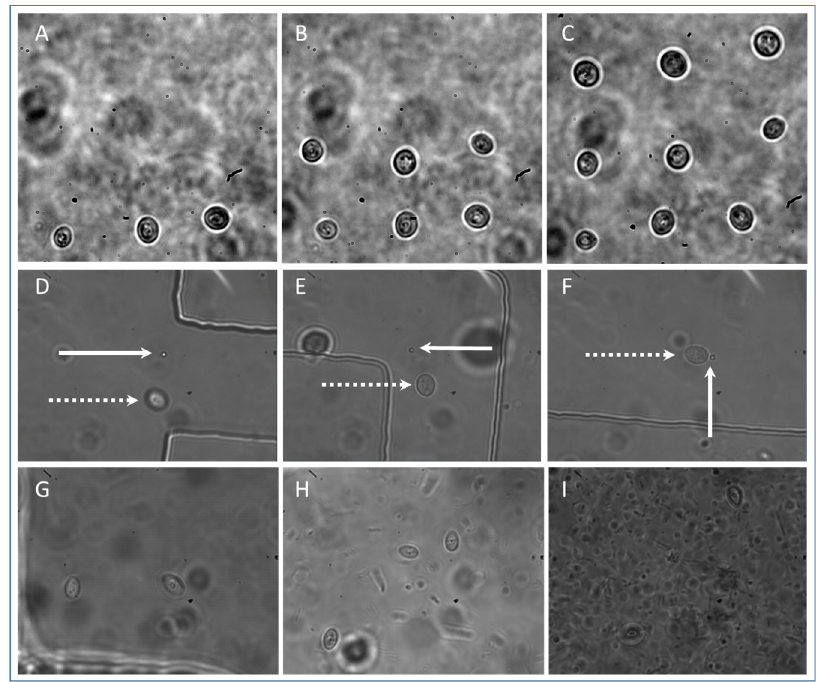
Figure 8. Setting up co-culture, ( A – C ) the creation of a 3 × 3 array of yeast cells; ( D – F ) a single S. cerevisiae yeast (dashed arrow) and single E. coli bacteria (solid arrow) tweezed through meandering channel in PDMS device into isolation chamber; ( G ) two yeast cells deposited by optical tweezers into PDMS isolation chamber at t = 0; ( H ) t = 1 day showing three yeast cells and bacterial contamination; ( I ) t = 5 days, two yeast cells are visible, the third is at the edge of the chamber and bacteria are numerous. The average diameter of the cells is 5 µ m and they are spaced approximately 10 µ m apart.